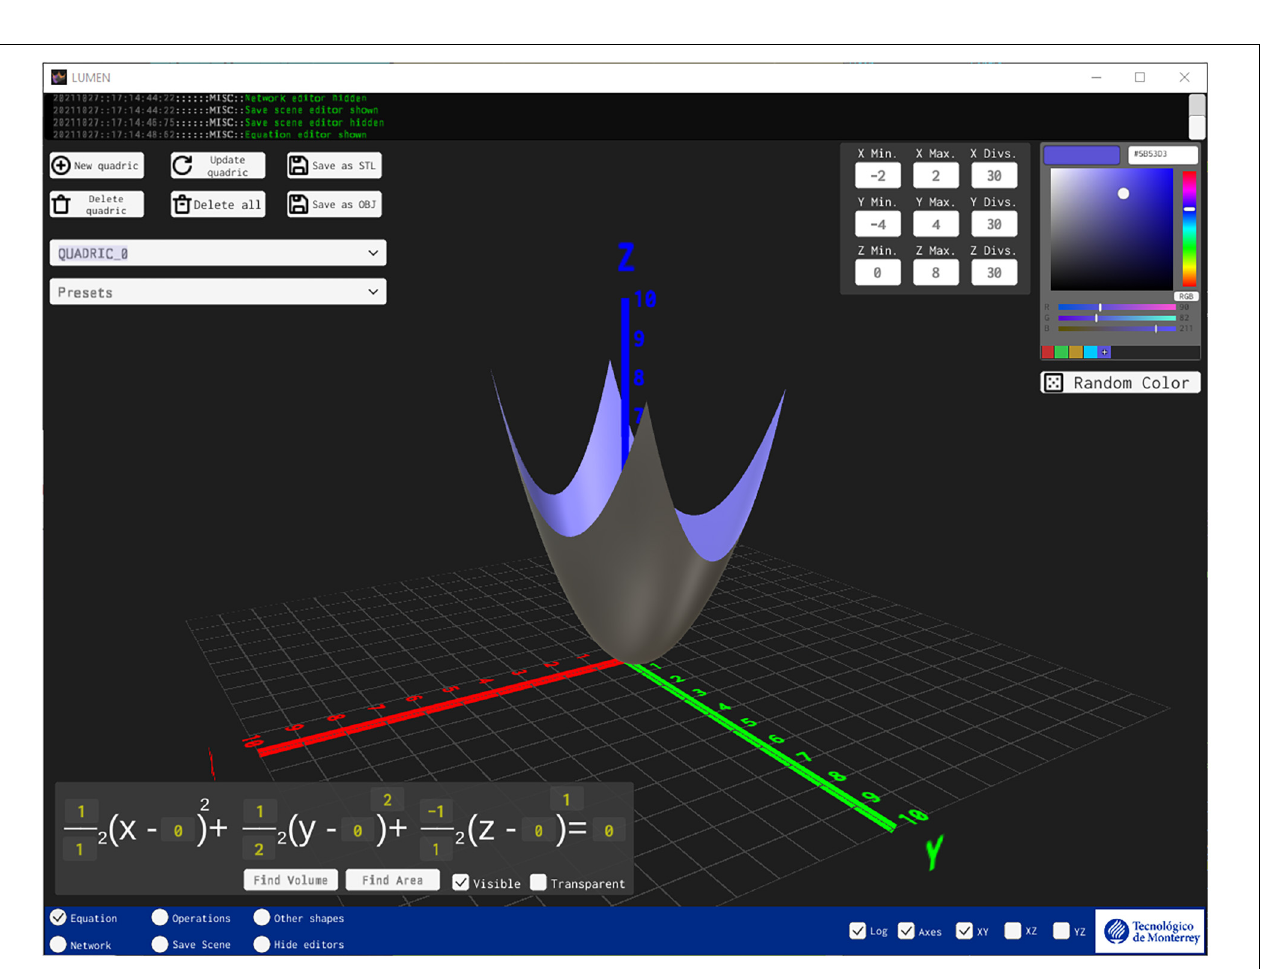
FIGURE 3 | User interface and menus for the Lumen